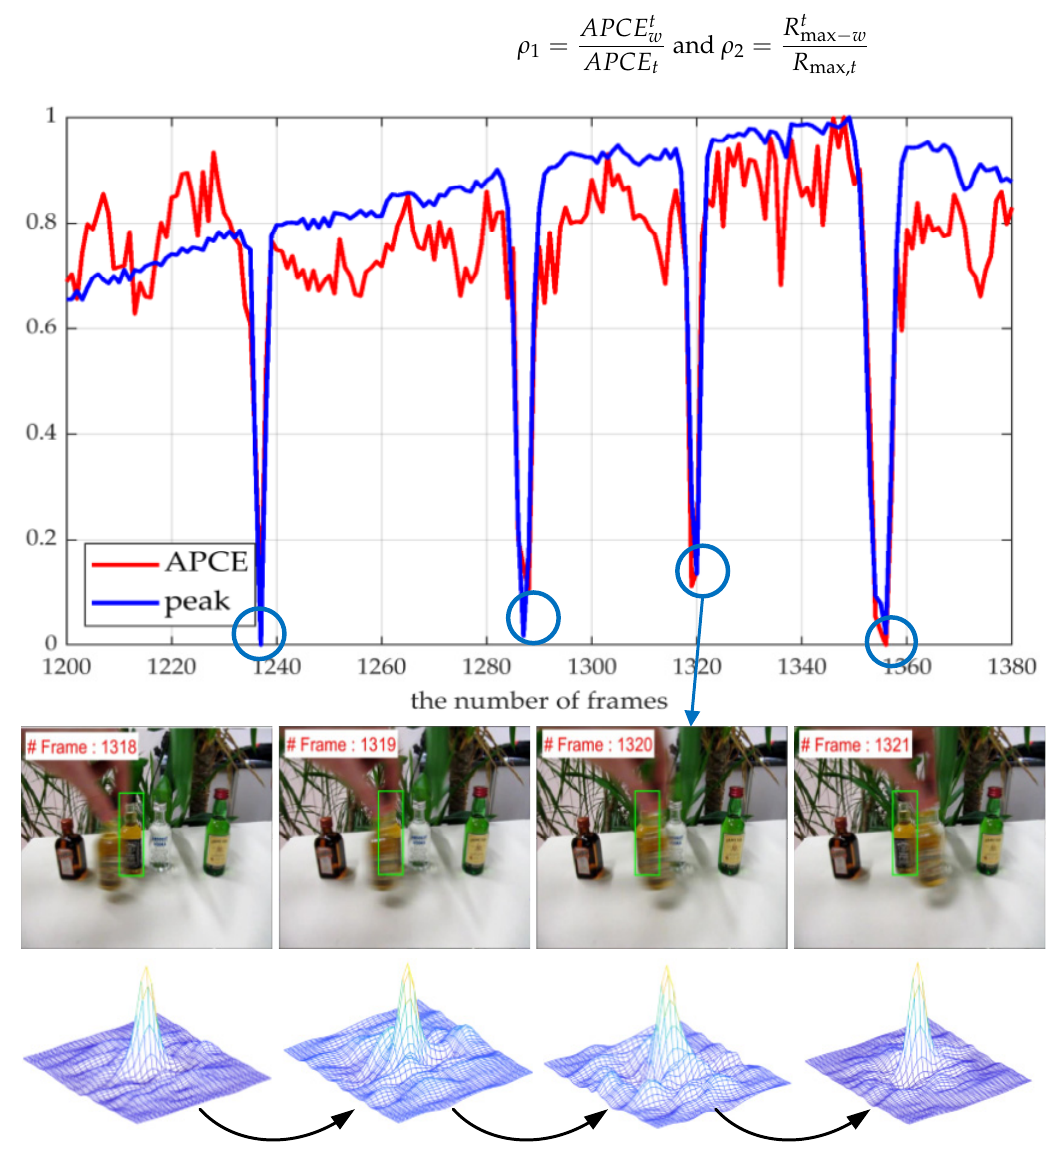
Figure 2. The APCE and peak normalized change curve of our Ad_SASTCA model on the sequence “Liquor” from 1200 frame to 1380 frame. Severe occlusion in frames 1237, 1287, 1230 and 1356 nearby will lead the APCE and peak of response to dropping sharply in a short period. Because the Ad_SASTCA does not fuse excessive incorrect information into the appearance model, the response map still indicates a sharp unimodal peak, and the model drift is